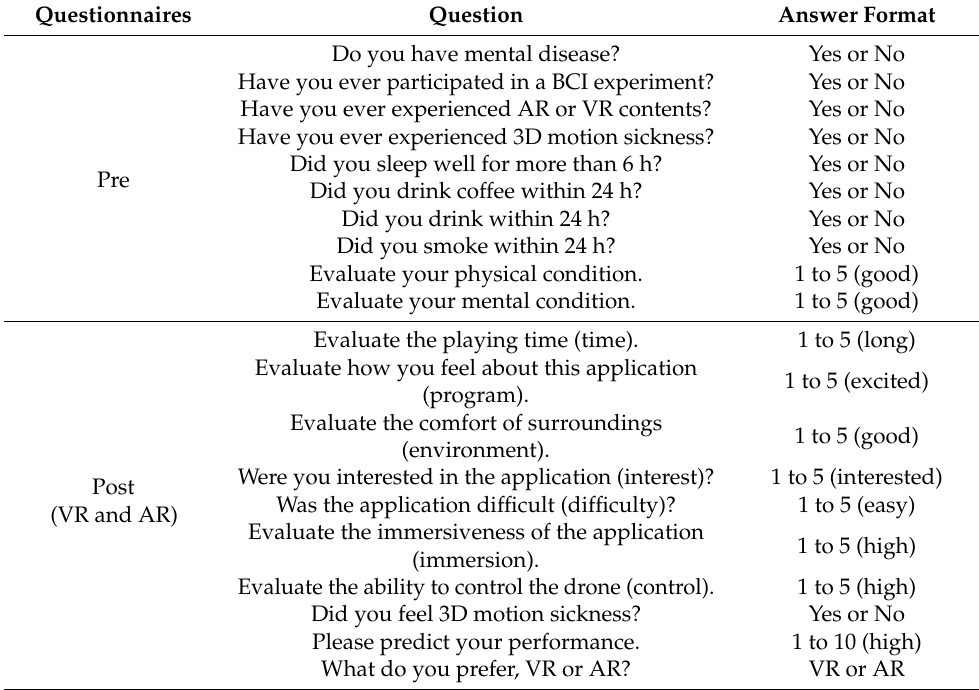
Table 2. Pre- and post-questionnaire items.